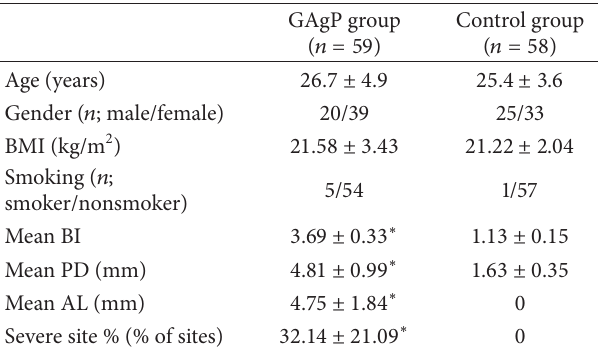
Table 1: Basic clinical characteristics of GAgP patients and healthy controls.